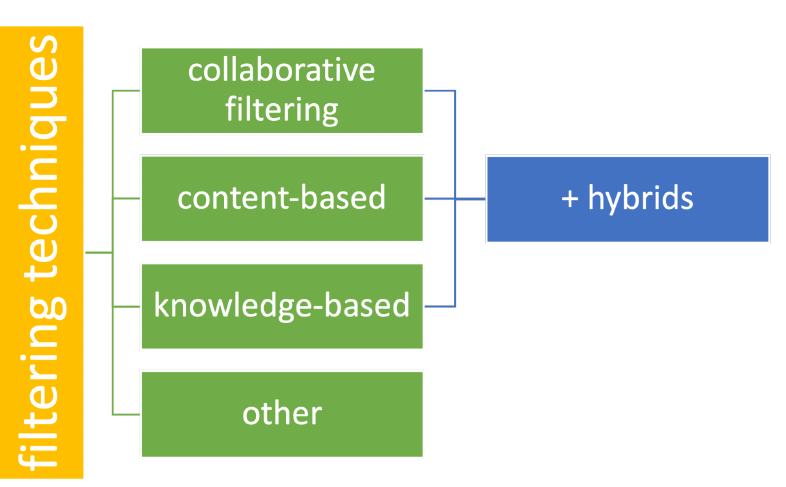
Figure 3. Recommender system types by filtering technique; the division devised by the authors for the sake of this work.